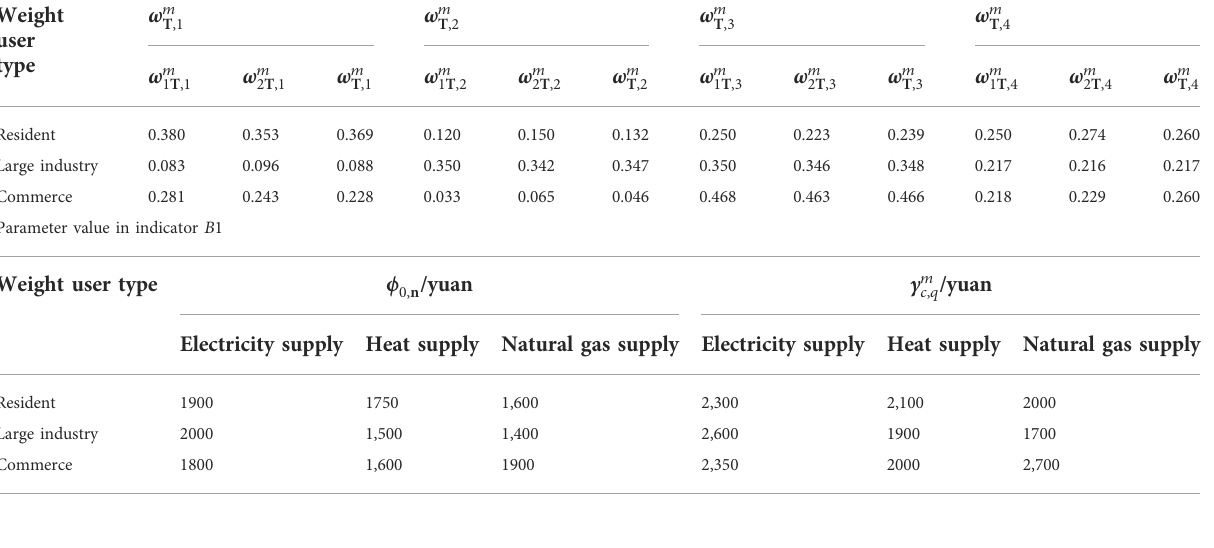
TABLE 1 Weight of index and parameter value of different types of users.